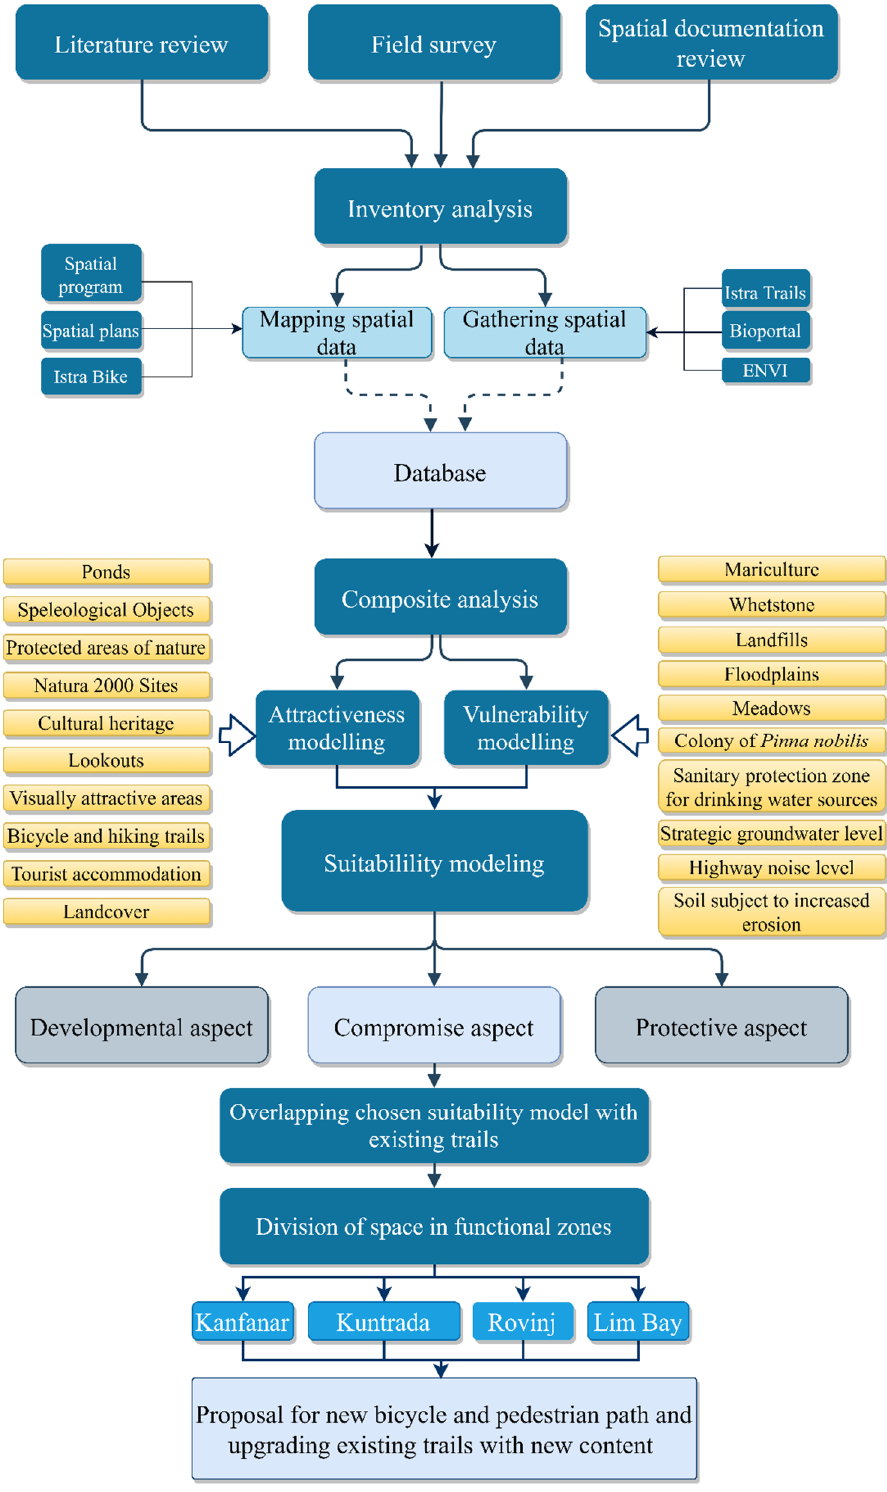
Figure 5. Flowchart of the methodology.